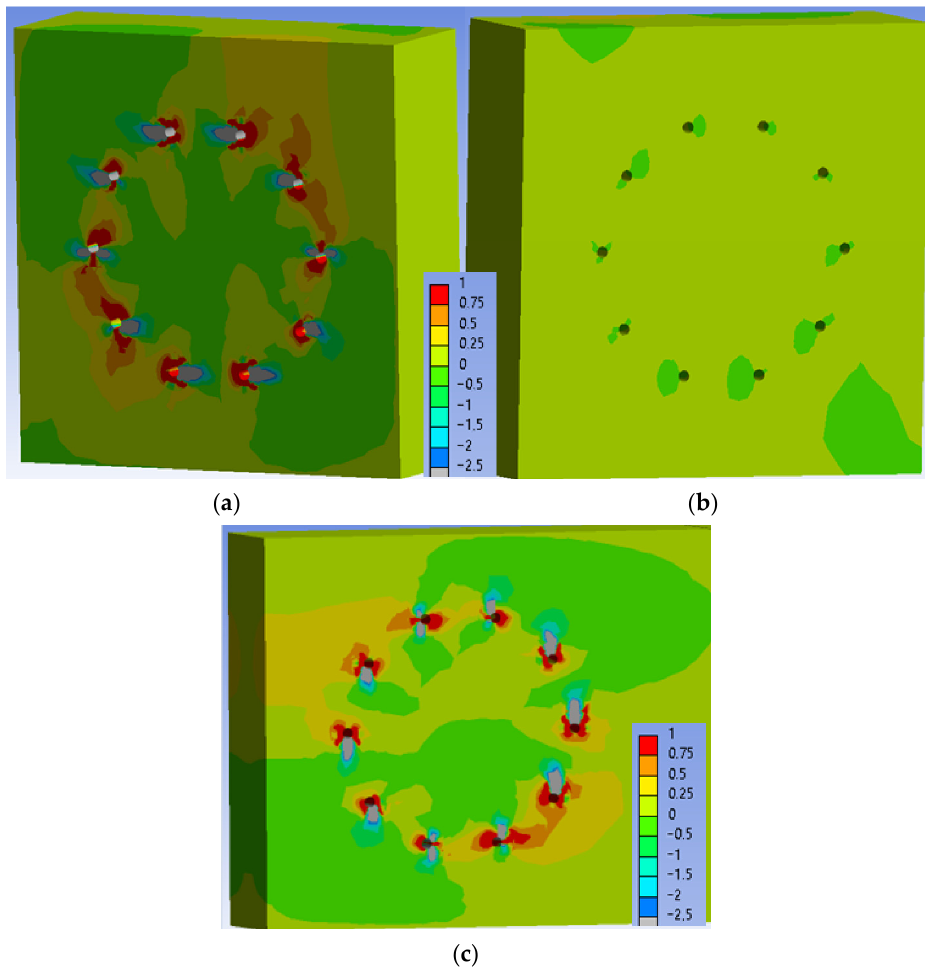
Figure 23. Tensile stress perpendicular to the grain [MPa] at 60% ULS, Experiment A: ( a ) inner side of the stand; ( b ) outer side of the stand; ( c ) rung.